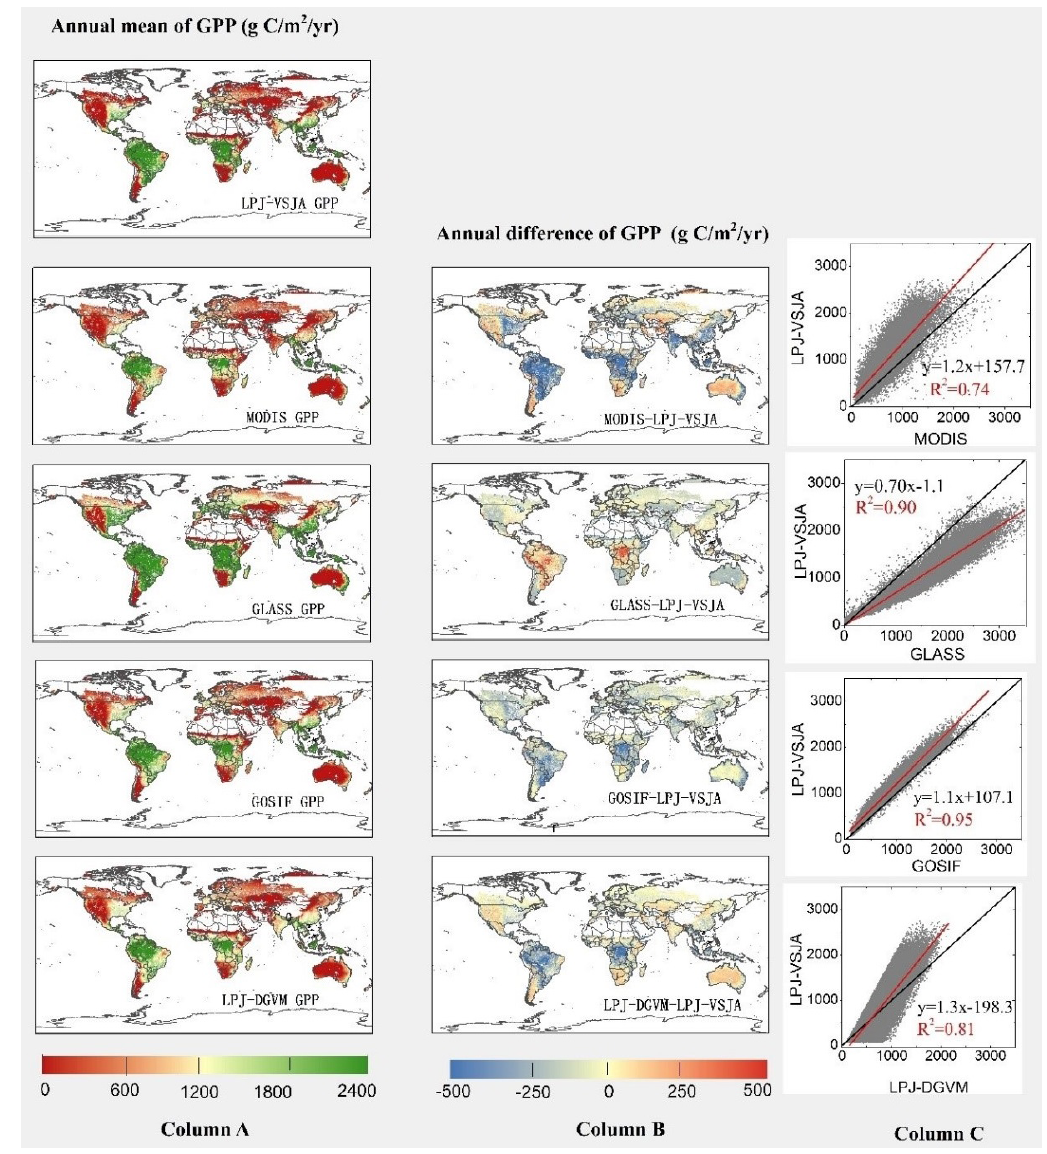
Figure 11. Column A: spatial distribution of annual LPJ-VSJA GPP and other independent satellite-based datasets. Column B: spatial distribution of the difference between annual LPJ-VSJA GPP and other independent satellite-based datasets. Column C: scatter plots between these products. Black lines show the 1:1 line, and red lines show the regression